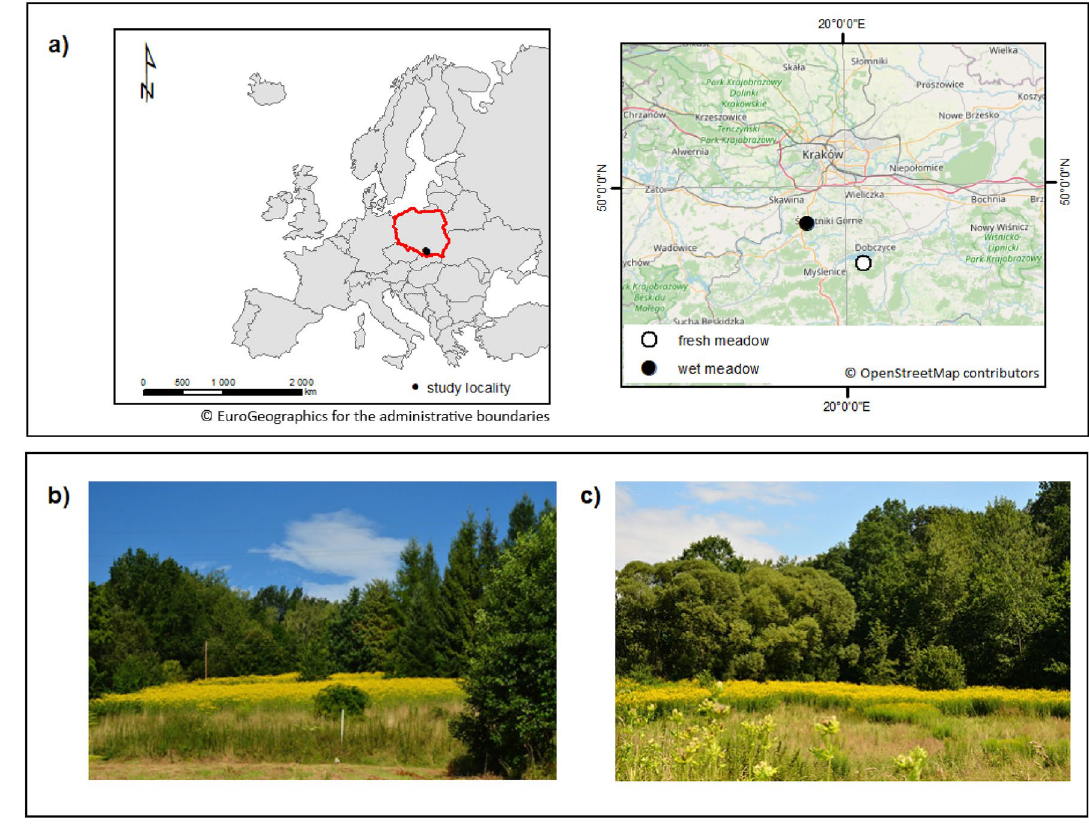
Figure 1. Study area. Location ( a ) and a view on the investigate plots: fresh ( b ) and wet ( c ) meadow. Yellow patches is Rudbeckia laciniata . Layer of European countries from Eurostat, topographic basemap from OpenStreetMap https:// www. opens treet map. org/ copyr